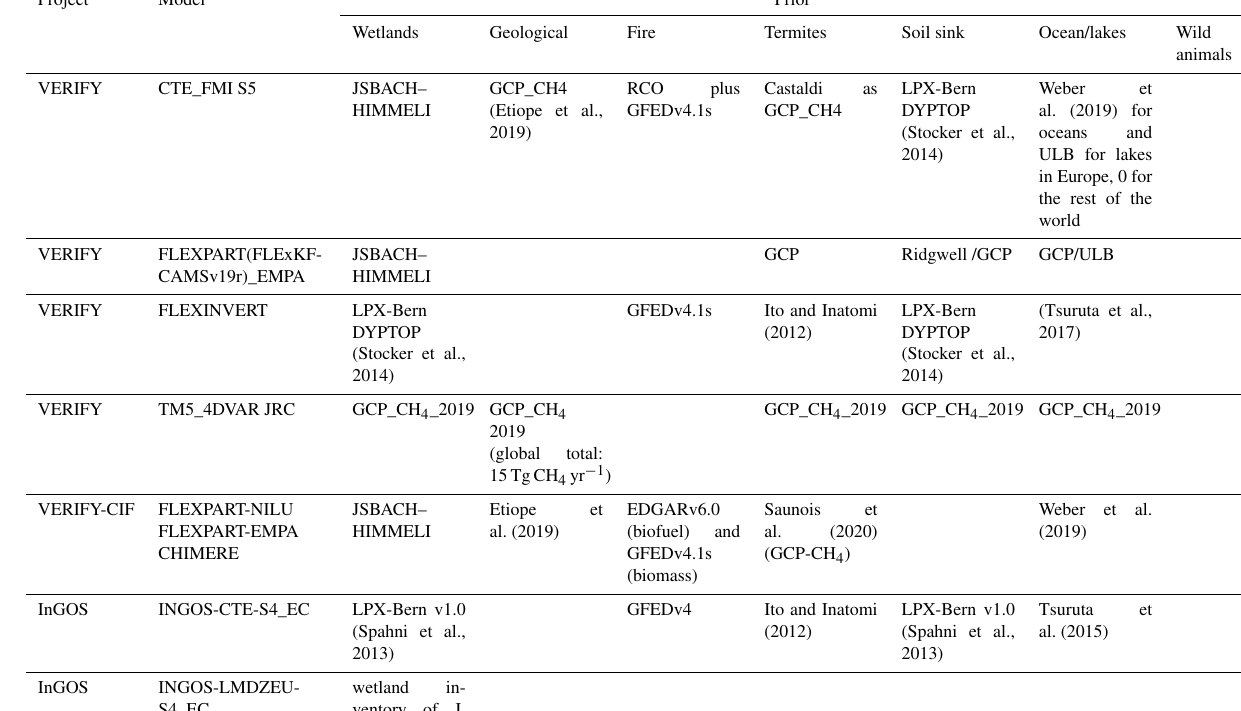
Table B4. List of prior datasets for natural CH 4 and N 2 O emissions used by all inverse models.